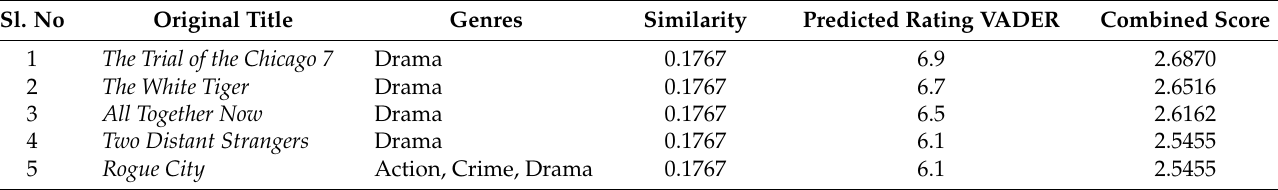
Table 12. Similar movies to the movie Taxi Driver .